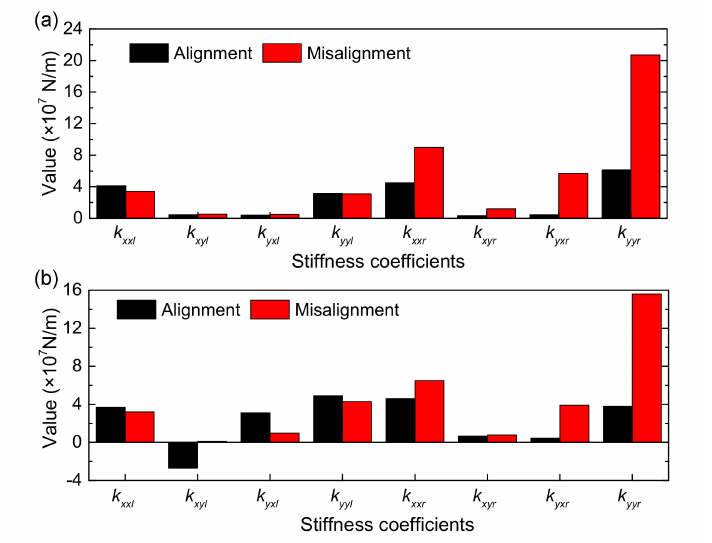
Figure 13. Bearing stiffness coefficients with shaft state at two rotational speeds: ( a ) 50 r/min; ( b ) 225